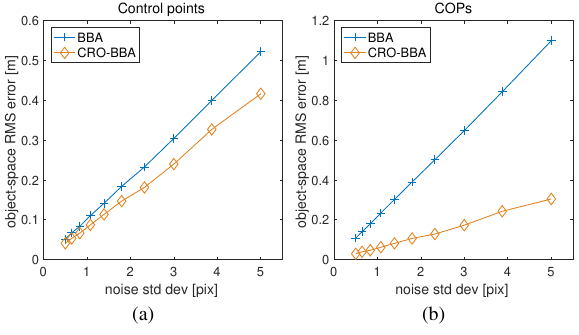
Figure 5. Object-space errors: RMS of the alignment residuals computed on control points (a) and COPs (b) vs image noise.